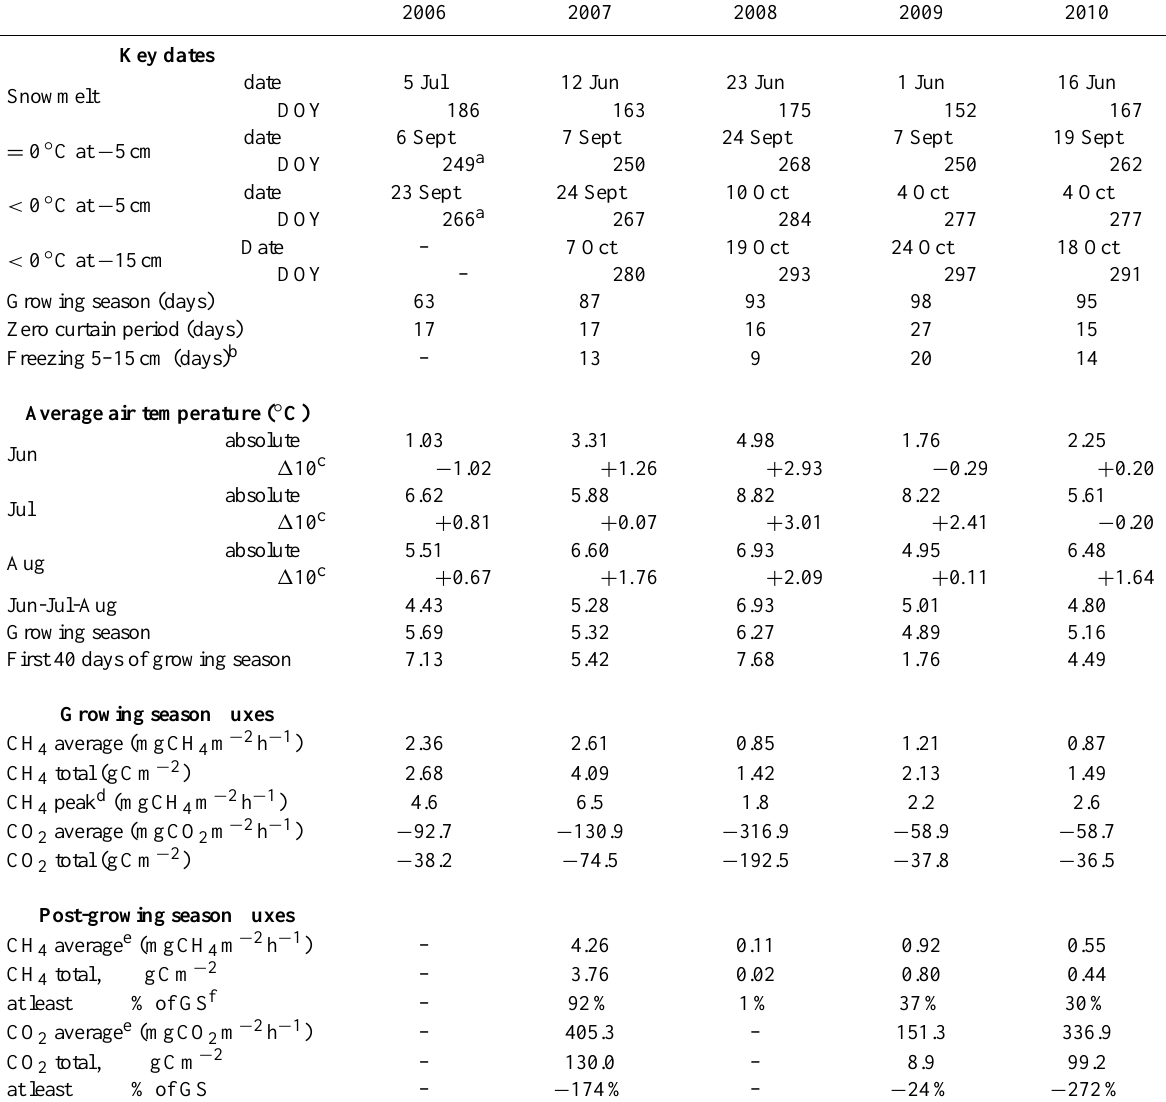
Table 1. Timing, temperature and flux values for five seasons,